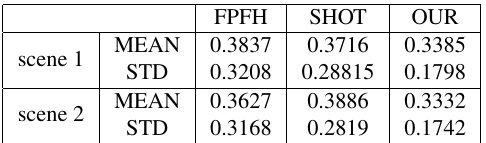
Figure 5. The e distribution of different descriptors on two test scenes.